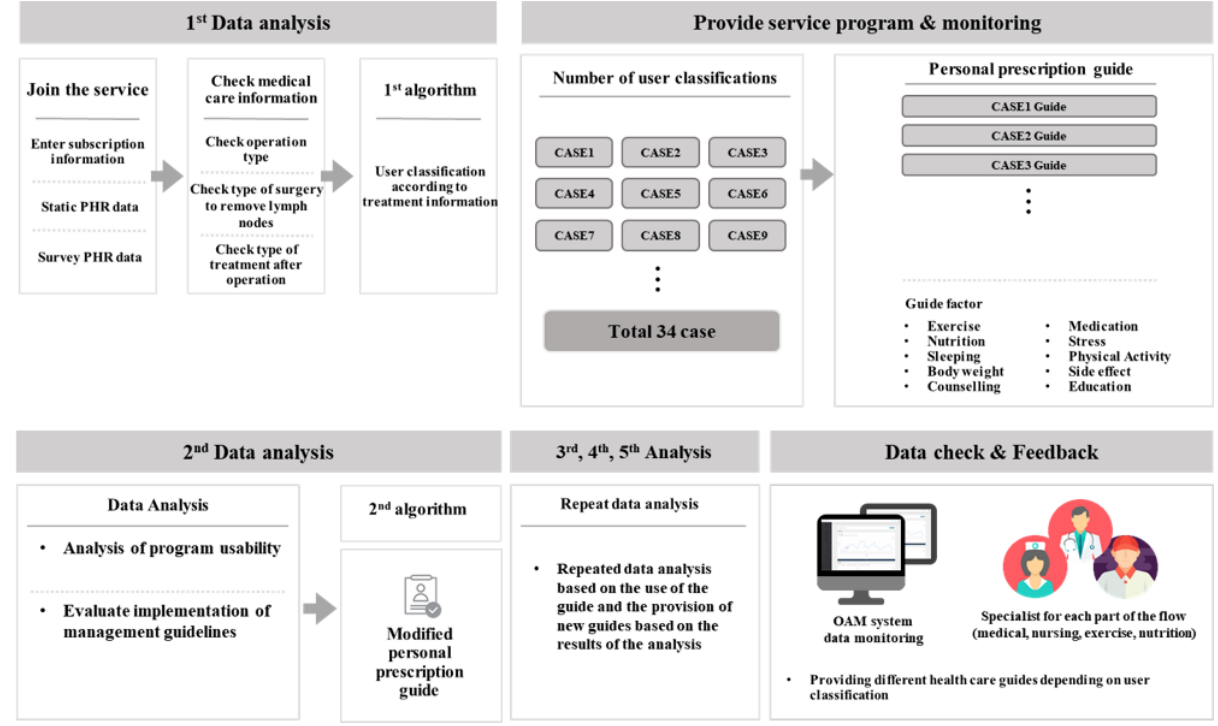
Figure 2. Service flowchart of the development of the modular mobile health (mHealth) app for personalized rehabilitation. OAM: open architecture management; PHR: personal health record.